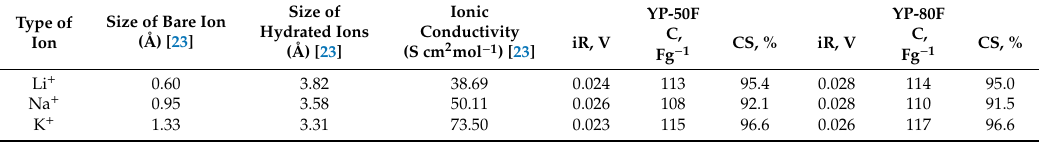
Table 1. Size and conductivity of electrolytic bare and hydrated ions, iR-drop, discharge capacitance and cycling stability (CS) for 1000 cycles of symmetric supercapacitors with YP-50F or YP-80F electrodes. Type of